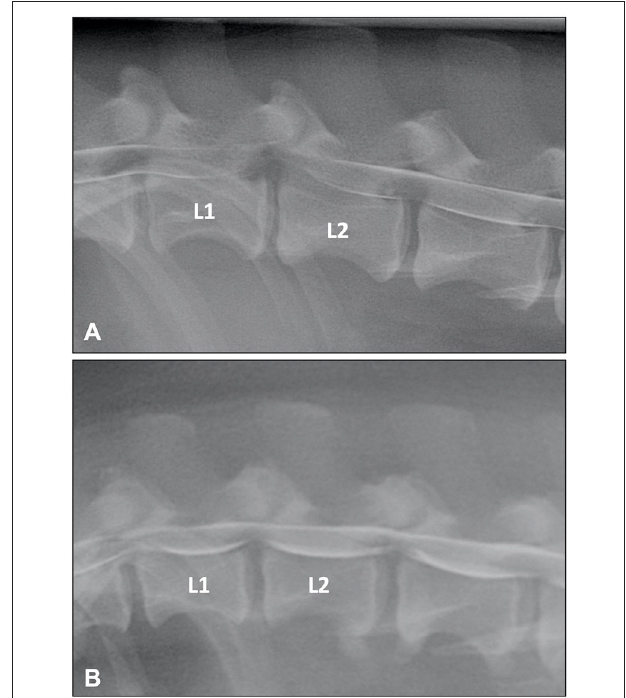
FIGURE 1 | (A) Lateral myelogram of a 5-year old Basset Hound with an L1-L2 IVDE. Thinning of the contrast columns is severe and the ventral contrast column is almost discontinued at L1-L2. Thinning of the contrast column is beyond the boundaries of the affected disc and distributed asymmetrical with a longer dorsal deviation of the ventral contrast column caudal to the affected disc. (B) Lateral myelogram of a 9-year old Basset Hound with IVDPs between L1-L2 and L2-L3. Thinning of the contrast columns is only mild, dorsal deviation of the ventral contrast column is centered over the affected disc spaces and distribution of contrast thinning is cranio-caudally symmetrical over the disc spaces.